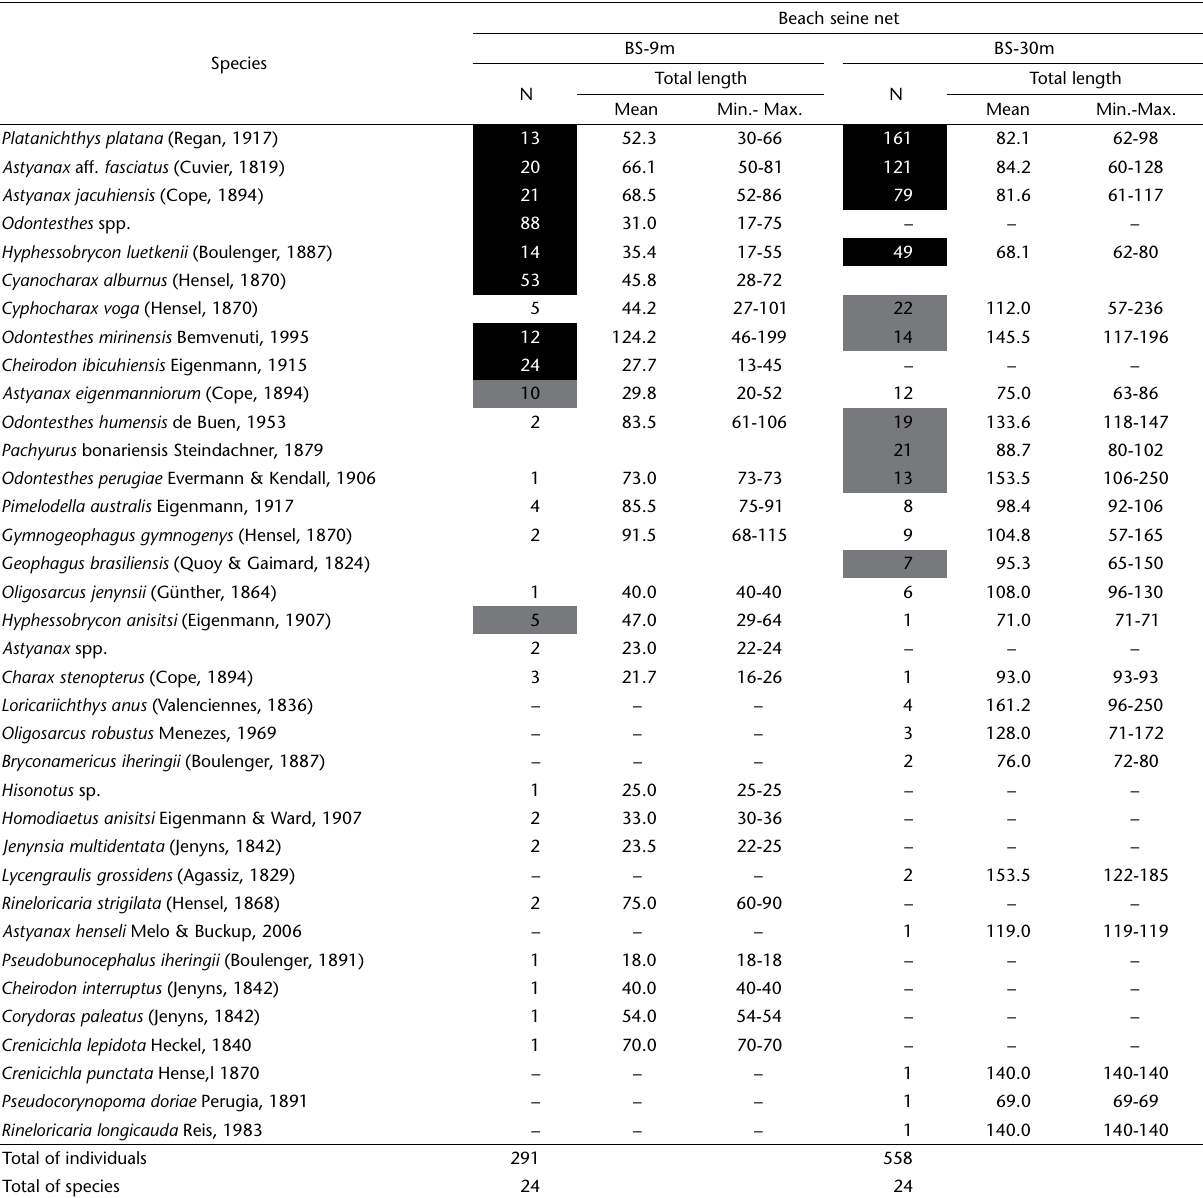
Table I. Comparative list of absolute abundance (N), structure size (minimum, maximum total length (Min-Max.) and total length mean (Mean)) and the relative importance (based on the FO% and N%), where: (black) frequent and abundant (gray) frequent and not abundant, and (colorless) present species caught with distinct beach seine nets. The fishes grouped on Genera were not counted as